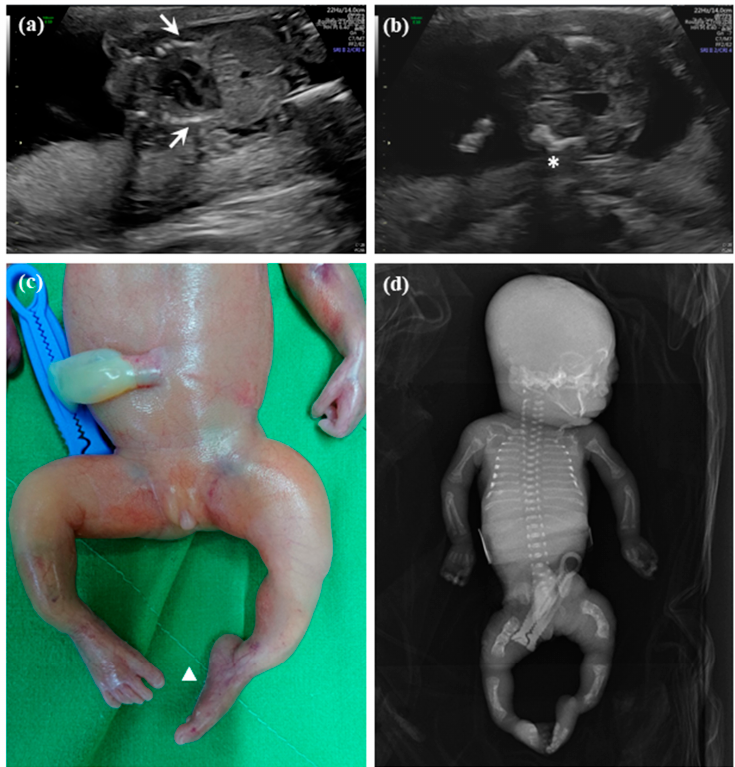
Figure 1. Prenatal ultrasonography of Patient 1 (a female fetus) with osteogenesis imperfecta type IX (OI IX), a kind of skeletal dysplasia (SD), in Family 1 at gestation age (GA) = 19 weeks and 5 days showed ( a ) bell-shape chest (arrow) and ( b ) bowing of femur (star). The appearance of the abortus